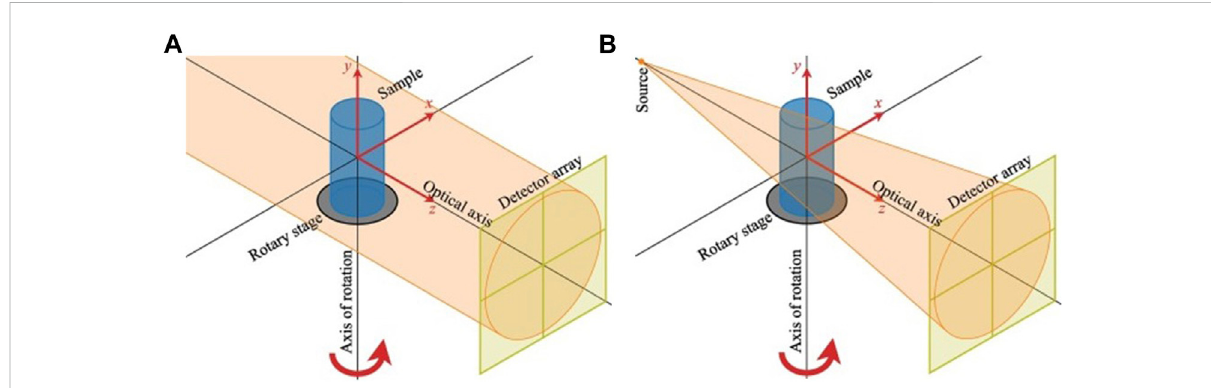
FIGURE 13 Principles of tomographic imaging (A) Parallel-beam, (B) Cone-beam (Brisard et al.,2020).